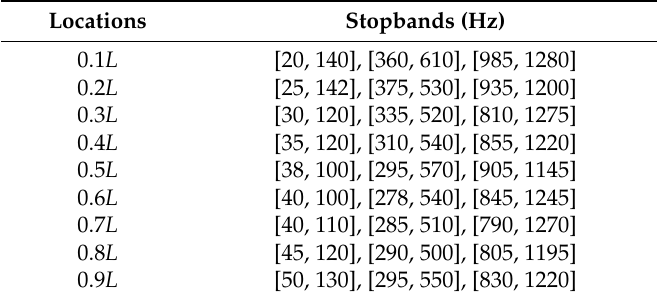
Table 4. Experimental stopbands derived from different crack locations.